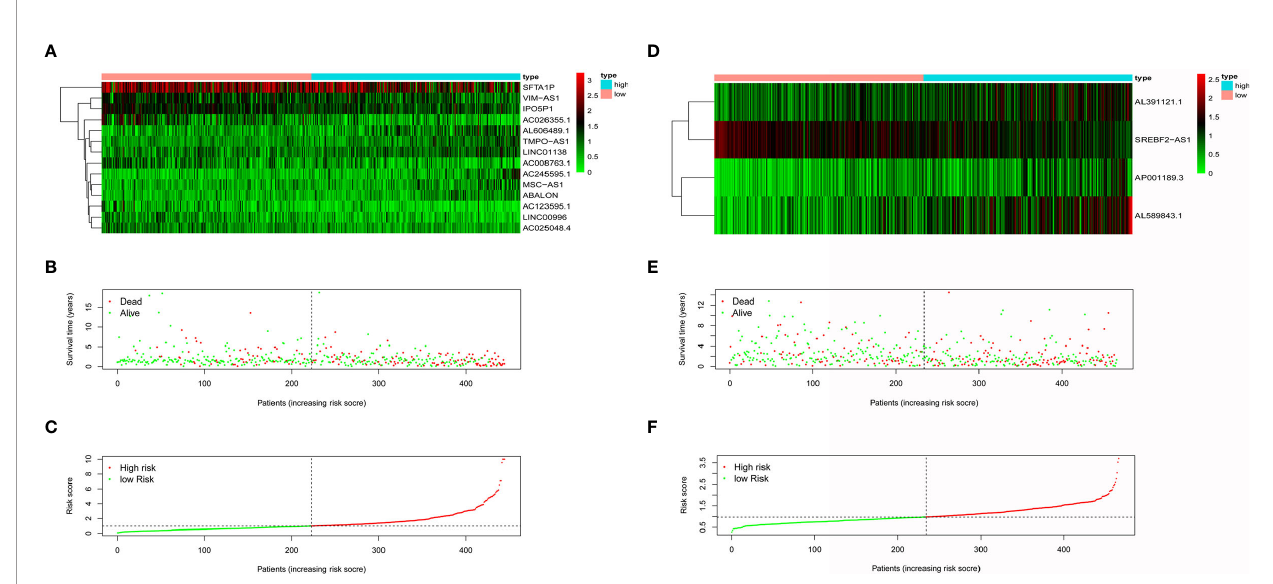
FIGURE 2 | The effectiveness evaluation of risk score. Heatmap of model lncRNAs expression level for AD patients (A) and SCC patients (D) in low-risk group and high group. Survival condition of AD patients (B) and SCC patients (E) in low-risk group and high group. Risk score curve of AD patients (C) and SCC patients (F) in low-risk group and high